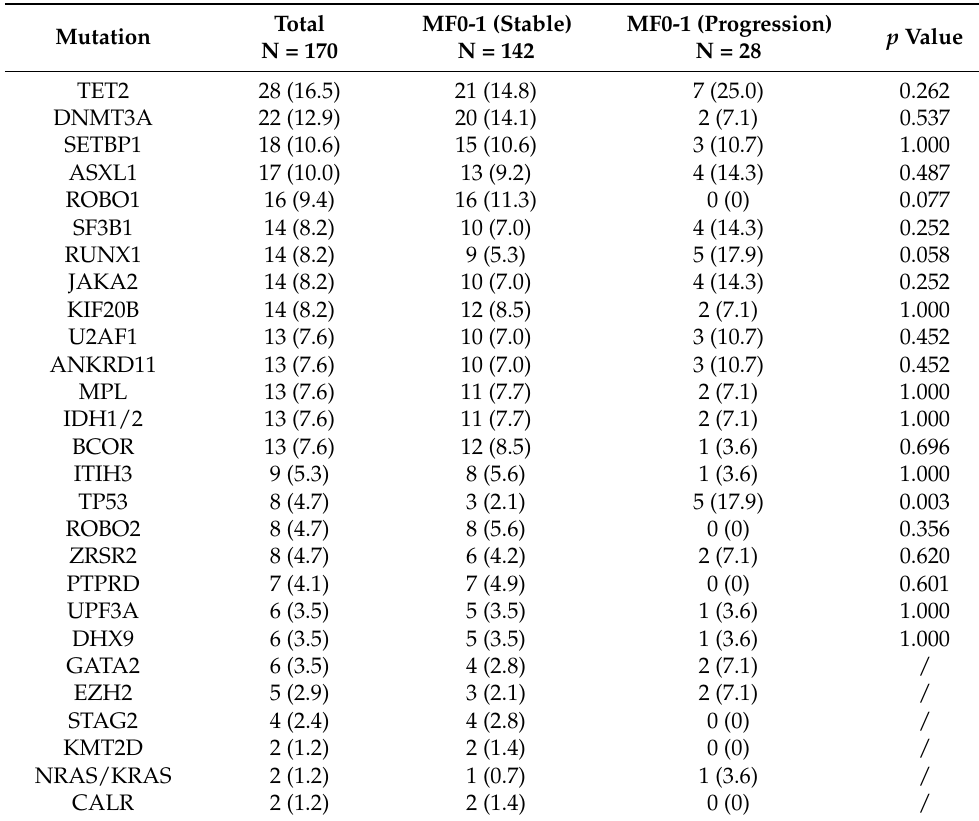
Table 4. Associations of mutations and BM fibrosis